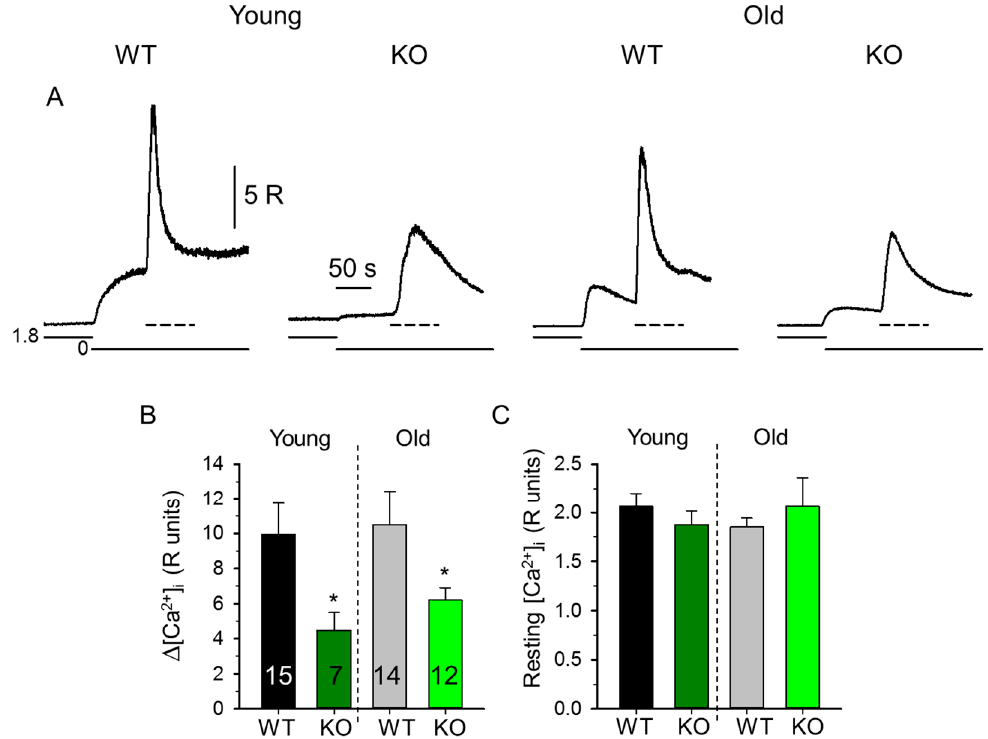
Figure 1. Decreased Ca 2 + transients in flexor digitorum brevis (FDB) fibers from small ankyrin1 (sAnk1) knockout (KO) mice. ( A ) Representative depletion cocktail evoked Ca 2 + transients measured on fibers isolated from the FDB muscles of 4- and 10-month-old wild type (WT) and sAnk1 KO mice. Pooled data for resting [Ca 2 + ] i ( C ), and maximal increase in [Ca 2 + ] i ( B ). The protocol of the solution exchange in panel A was: 0–70 s normal Tyrode’s solution (1.8, solid line), 70–300 s Ca 2 + -free Tyrode’s with 5 mM EGTA (0, solid line), 150–220 s releasing cocktail (200 µ M 4-chloro-M-cresol and 10 µ M cyclopiazonic acid) in Ca 2 + -free Tyrode’s (dashed line). Numbers in columns show the number of fibers averaged. The number of animals in groups varied between 3 and 4. * denotes significant di ff erence from WT at p < 0.05.